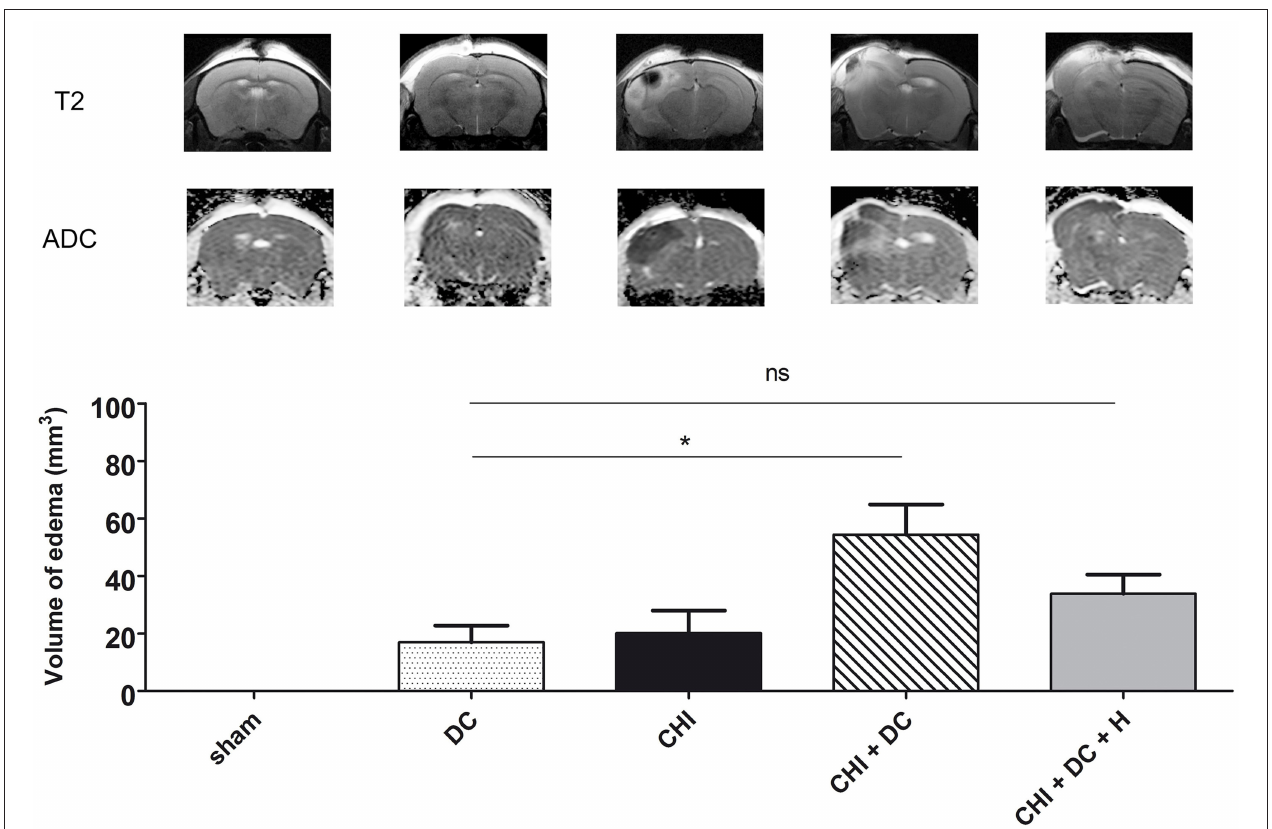
FIGURE 1 | Demonstrating radiological sequelae (in particular brain edema) of trauma/surgery in experimental groups used for the current analysis. The upper panel displays the representative MRI scans obtained 24h after trauma/sham treatment using a 9.4 Tesla scanner. There are apparent differences between the groups in pattern of brain edema (with CHI + DC group being most severely affected), as presented on T2-weighted images and on ADC maps. Below, the histogram represents quantitative analysis of ADC maps in regard to volume of brain edema. The volumetric data obtained here were used as one of the variables in correlation analysis in current study (*, p < 0.05; ns, p > 0.05). ADC, apparent diffusion coefficient; CHI, closed head injury; DC, decompressive craniectomy; H, hypothermia; MRI, magnetic resonance imaging. Adapted from Szczygielski et al. (39); © Mary Ann Liebert, Inc., New Rochelle, NY. Adapted with